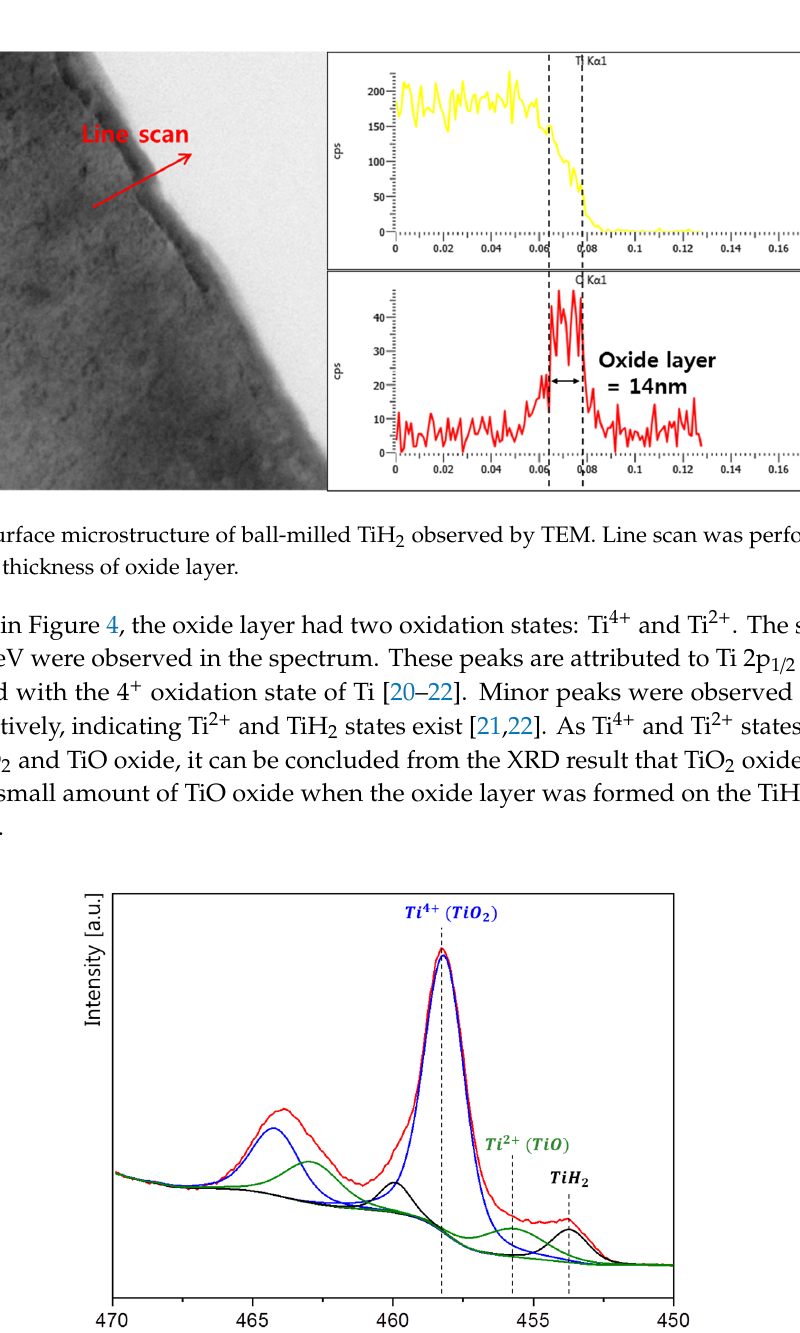
Figure 3. Surface microstructure of ball-milled TiH 2 observed by TEM. Line scan was performed to analyze the thickness of oxide layer.